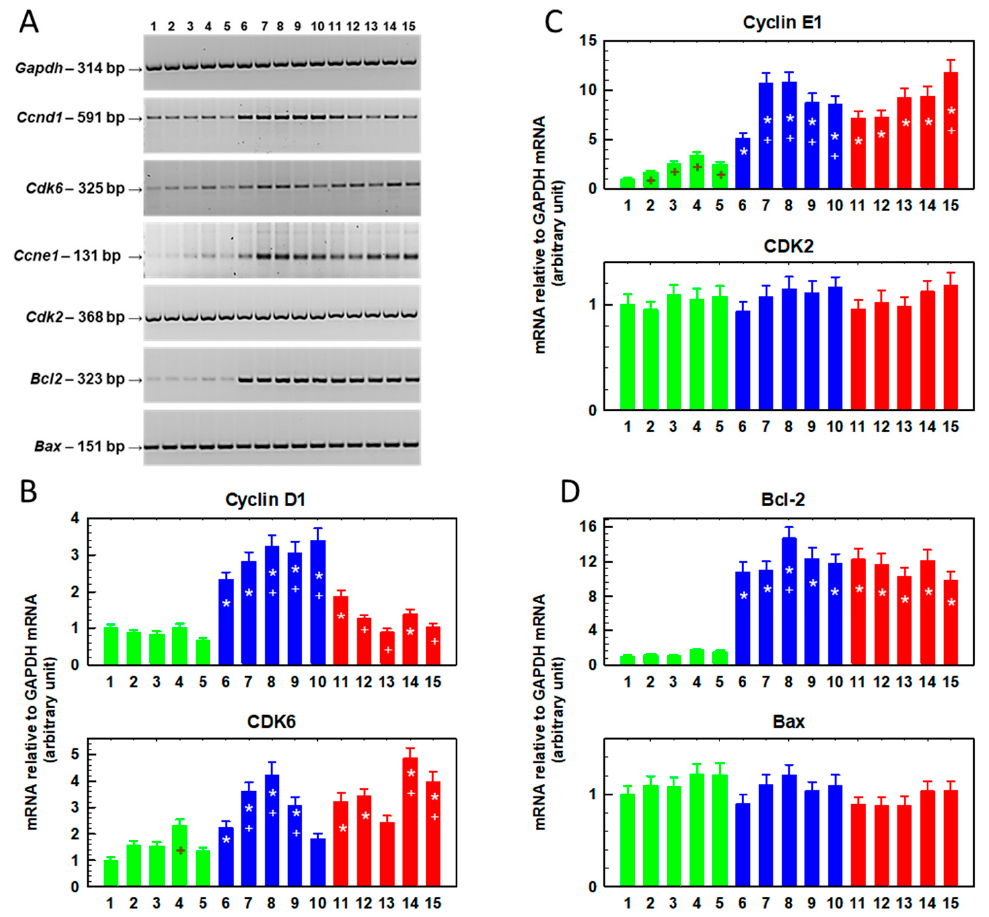
Figure 2. Changes in the relative gene expression of Ccnd1 (for cyclin D1), Cdk6 (for cyclin-dependent kinase 6), Ccne1 (for cyclin E1), Cdk2 (for cyclin-dependent kinase 2), Bcl2 and Bax in S, R and T cells passaged once in SFN-containing medium. The cells were cultured for 48 h in the presence of SFN at the following concentrations: (1) 0.0 µ M S cells, (2) 2.5 µ M S cells, (3) 5.0 µ M S cells, (4) 7.5 µ M S cells, (5) 10.0 µ M S cells, (6) 0.0 µ M R cells, (7) 2.5 µ M R cells, (8) 5.0 µ M R cells, (9) 7.5 µ M R cells,